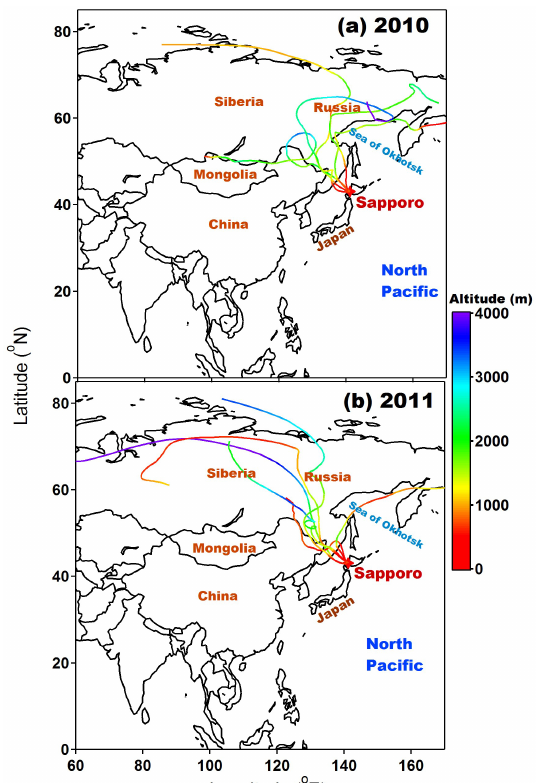
Figure 1. Air mass back-trajectory cluster at an arrival height of 500ma.g.l. (above ground level) for the sampling days in (a) winter 2010 and (b) winter